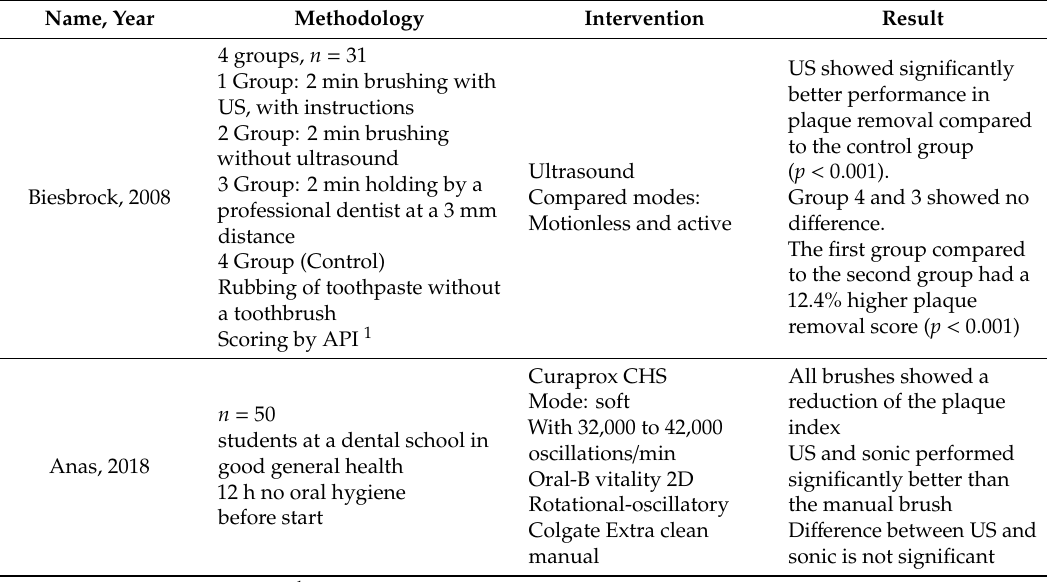
Table 3. Single-brushing studies on the sonic toothbrushing e ff